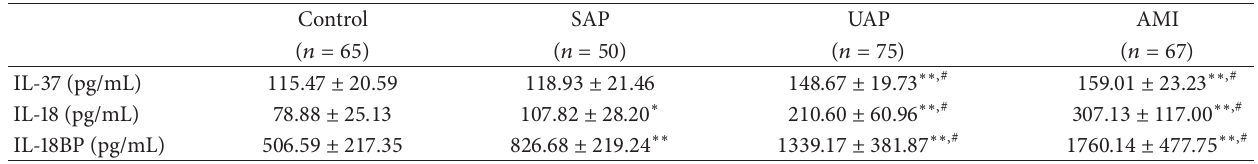
Figure 1: The plasma IL-37, IL-18, and IL-18BP levels in each group. (a) The plasma IL-37 levels in patients with AMI and UAP were significantly increased compared with those of the control and SAP groups. (b) The plasma IL-18 levels in patients with AMI and UAP were significantly increased compared with those of the control and SAP groups, and the plasma IL-18 levels in patients with SAP were significantly increased compared with those of the control group. (c) The plasma IL-18BP levels in patients with AMI and UAP were significantly increased compared with thoseof thecontrol and SAP groups,and theplasma IL-18BPlevels inpatients with SAP were significantly increased compared with those of the control group. (d) The levels of IL-37 were positively correlated with the levels of IL-18 ( 𝑟 = 0.56 , 𝑃 < 0.01 ). (e) The levels of IL-37 were positively correlated with the levels of IL-18BP ( 𝑟 = 0.55 , 𝑃 < 0.01 ). (f) The levels of IL-18 were positively correlated with the levels of IL-18BP ( 𝑟 = 0.72 , 𝑃 < 0.01 ). ∗ 𝑃 < 0.05 versus Control, ∗∗ 𝑃 < 0.01 versus Control, ## 𝑃 < 0.01 versus SAP. Table 2: Plasma biomarker levels in each